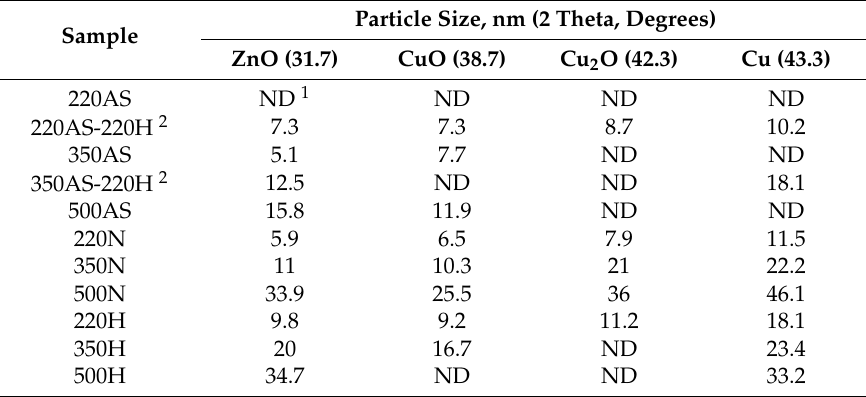
Table 1. The crystallite size of ZnO, CuO, Cu 2 O, and Cu present in the catalysts prepared by calcination in different atmospheres at different